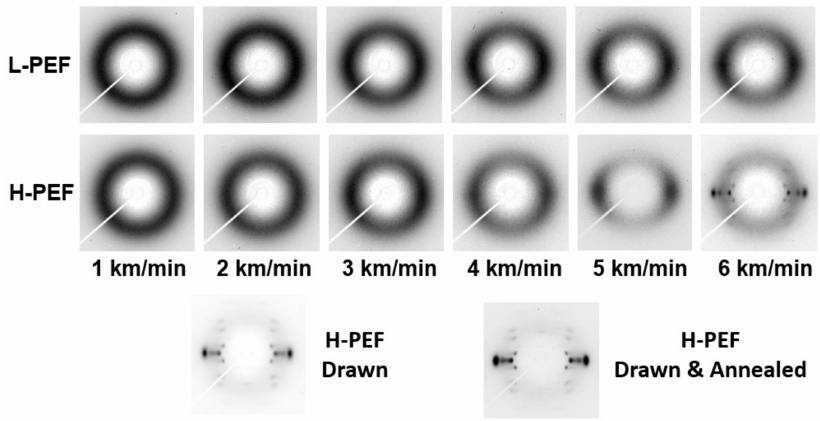
Figure 2. Wide-angle X-ray diffraction (WAXD) patterns of high-speed spun PEF fibers obtained at various take-up velocities. WAXD patterns of drawn fiber and drawn and annealed fiber are also shown for